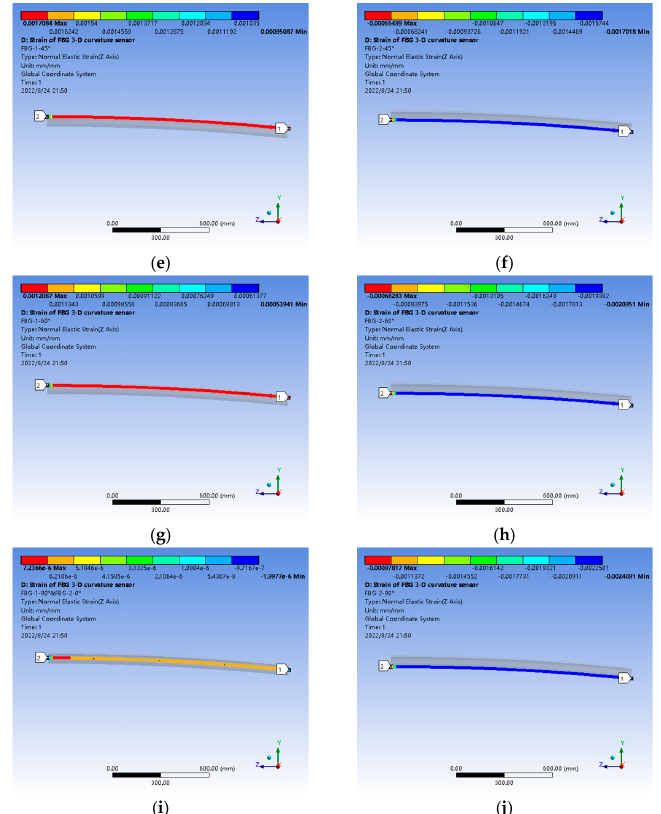
Figure 6. Strain nephogram of orthogonal FBG under different rotation error angles. ( a ) The rotation angle error of FBG I is 0°; ( b ) the rotation angle error of FBG II is 0°; ( c ) the rotation angle error of FBG I is 30°; ( d ) the rotation angle error of FBG II is 30°; ( e ) the rotation angle error of FBG I is 45°; ( f ) the rotation angle error of FBG II is 45°; ( g ) the rotation angle error of FBG I is 60°; ( h ) the rotation angle error of FBG II is 60°; ( i ) the rotation angle error of FBG I is 90°; ( j ) the rotation angle error of FBG II is 90°. It can be seen that since the FBG curvature sensor maintains a specific curvature of 15,000 mm in the simulation, its surface strain is roughly equal along the axis direction, and the surface strain value shows a gradual change and symmetrical distribution along the circumference, ignoring the stress concentration at the two ends of the constraint and load. In the rotation error angle range of 0~90°, FBG I is in tension, and its strain value decreases with the increase in rotation error angle. In the rotation error angle range of 0~90°, FBG II is compressed, and its strain value increases with the increase in rotation error angle. Ignoring the strain transfer efficiency between the FBG and the matrix material, the path center strain value is derived in ANSYS Workbench, which can be regarded as the strain value of the FBG. Based on the simulated strain value, the curvature radius can be